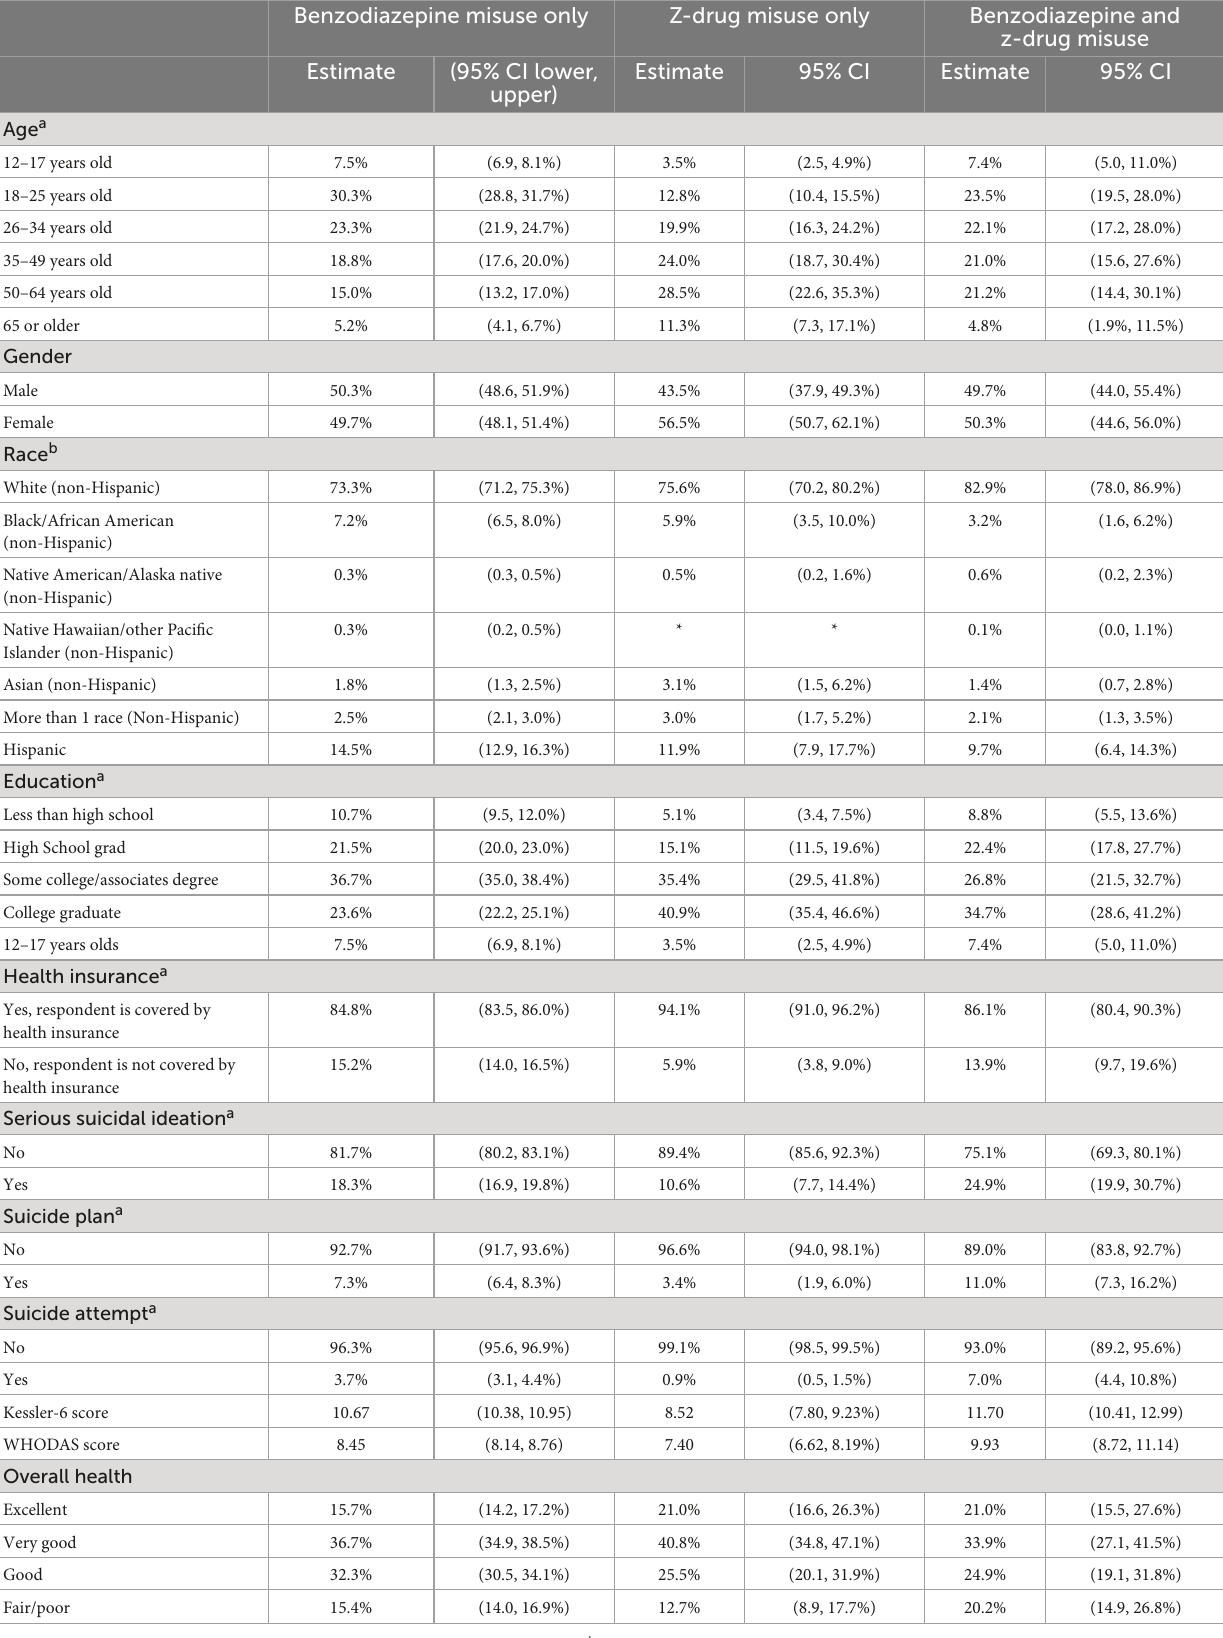
TABLE 1 Population estimates of sociodemographic characteristics of people with past-year benzodiazepine and/or z-drug misuse. Benzodiazepine misuse only Z-drug misuse only Benzodiazepine and z-drug misuse Estimate (95% CI lower, upper)